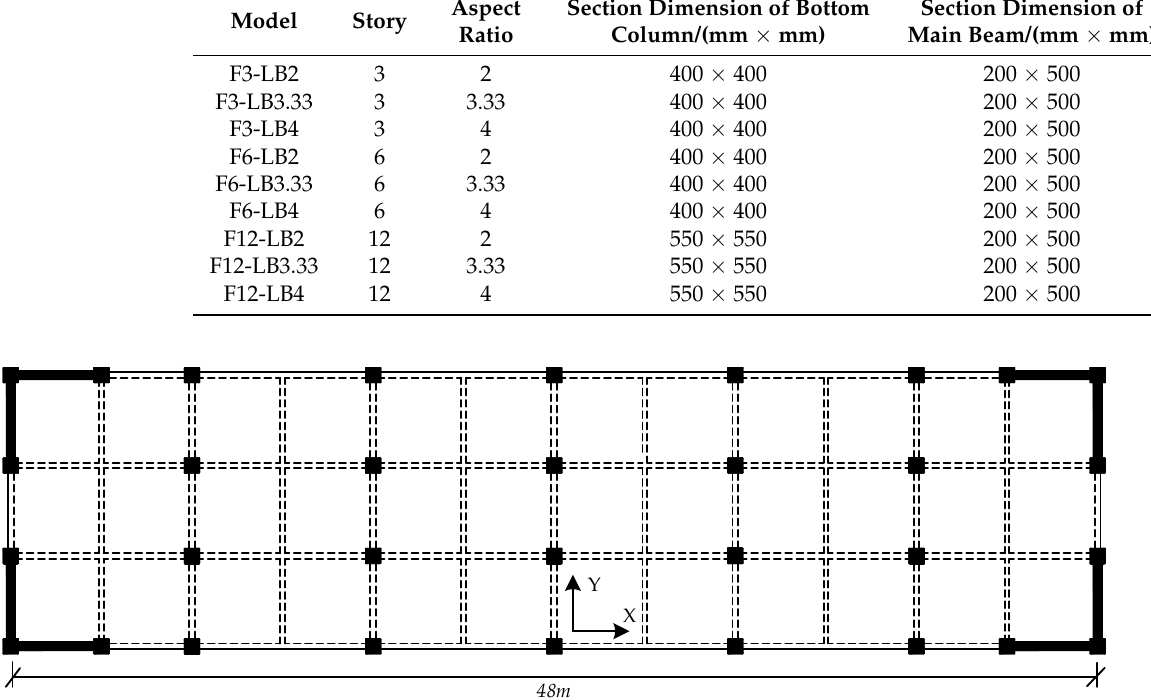
Figure 2. Plane arrangement of structure with an aspect ratio of 4.